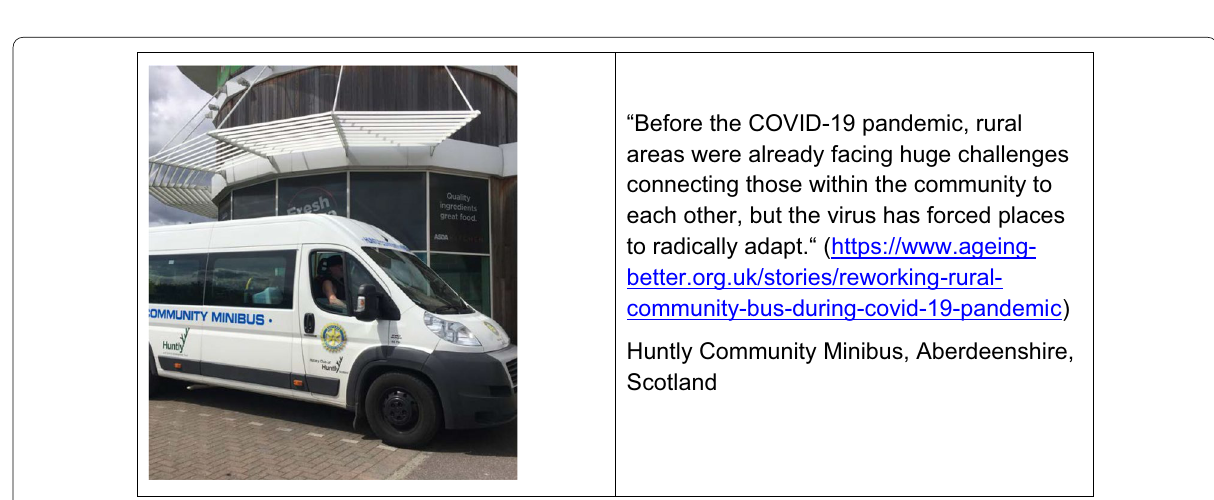
Fig. 1 Use of local public transport in Sweden before and after the pandemic (% of responses) ( Source: ITF survey, 2021)